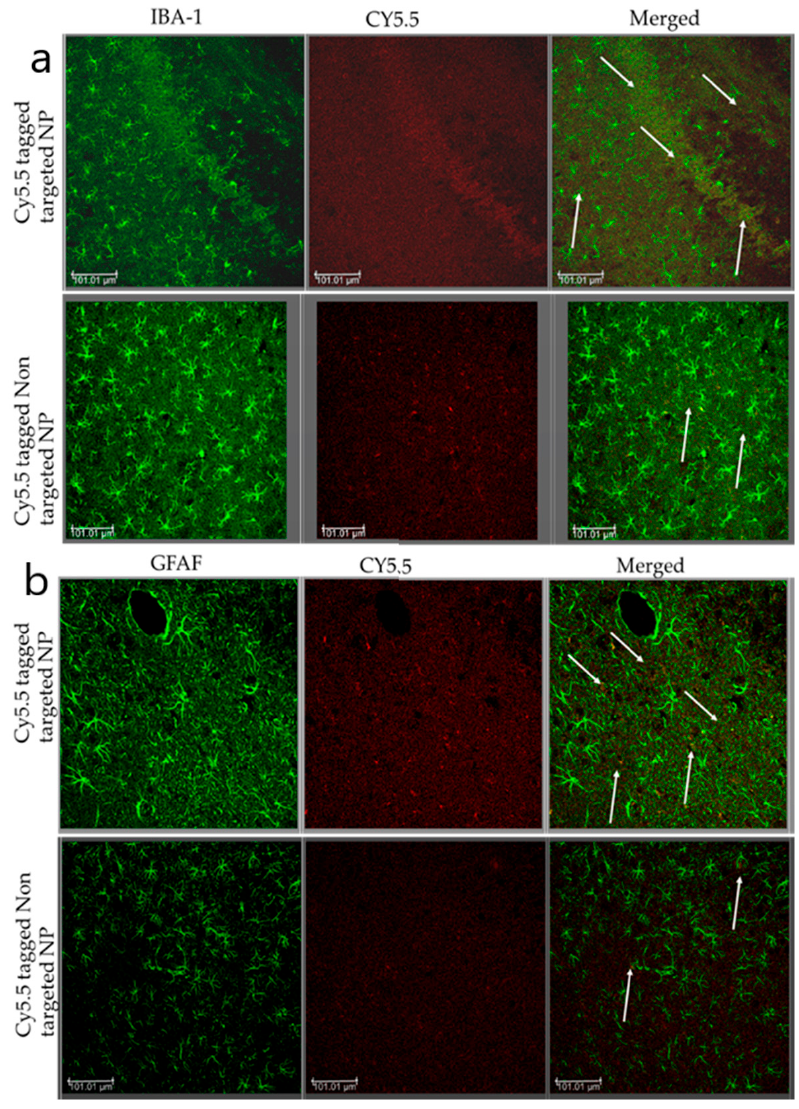
Figure 8. Nanoparticles internalized in the brain parenchyma and glial cells by crossing the BBB and actively targeting via transferrin receptors. bTBI rats were intravenously injected with Cy5.5 conjugated MANP or tfMANP and then sacrificed 6 h after the injection. Brain tissues were collected 6 h after injections of Cy5.5 conjugated MANP or tfMANP. Sections were observed under a confocal microscope. The distribution in the brain parenchyma and uptake of Cy5.5 conjugated MANP and tfMANP (white) by ( a ) microglia and ( b ) astrocytes is shown. Scale bar = 100 µm.